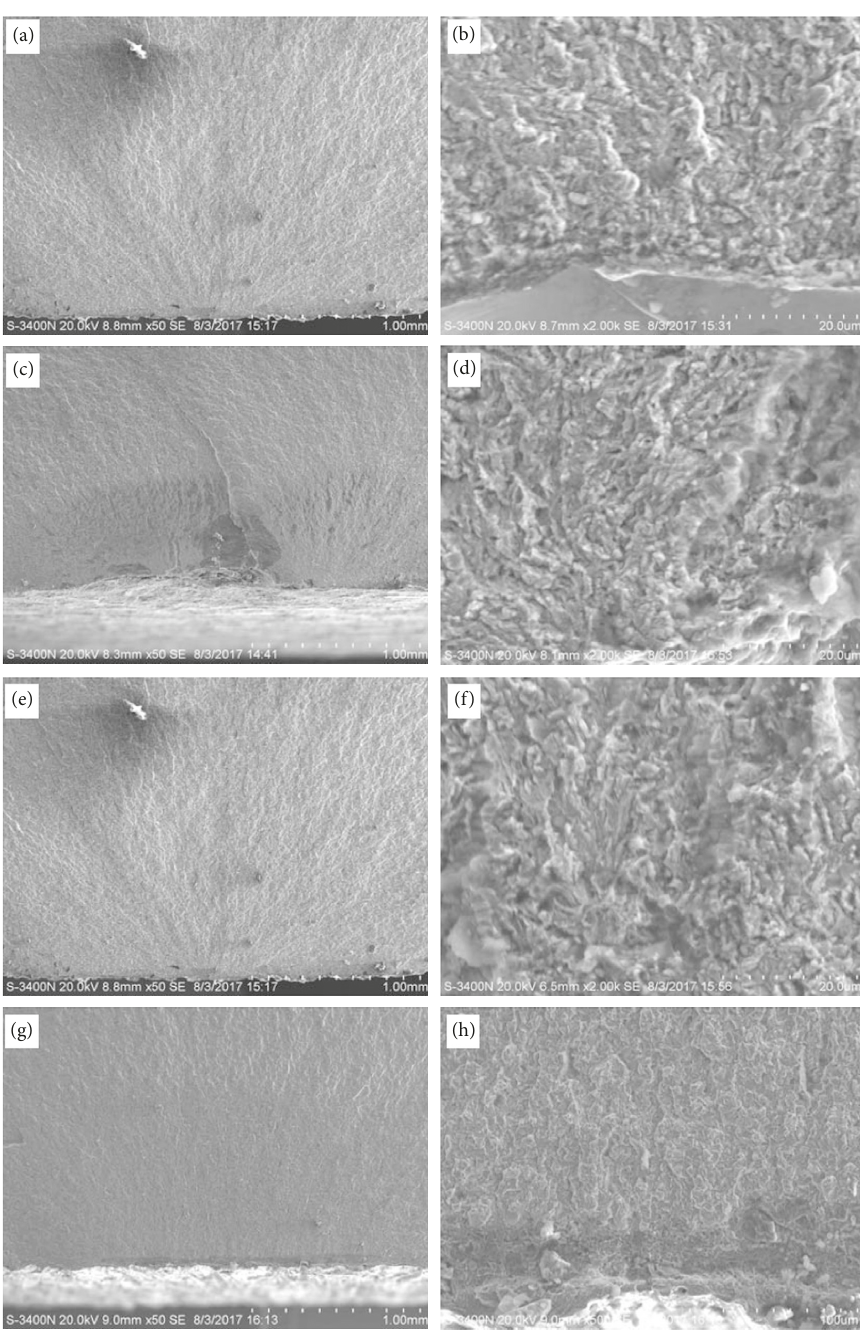
Figure 5: Typical fractures at the crack initiation zone of (a–d) the pipe bodies and (e–h) weld joints (a, b, e, f) with and (c, d, g, h) without surface